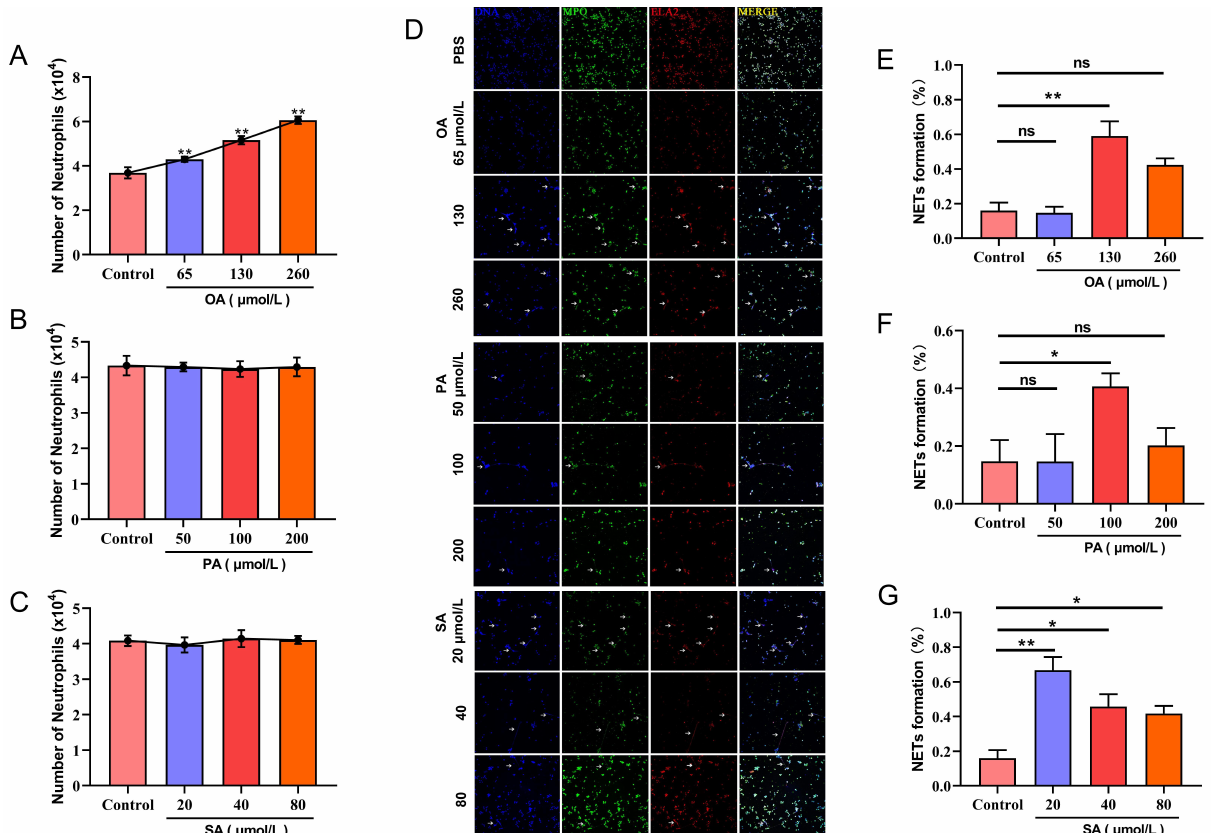
Figure 2. Effects of OA, PA, and SA on migration and NET formation of PMN. ( A ) Effects of OA on migration of PMN; ( B ) effects of PA on migration of PMN; ( C ) effects of SA on migration of PMN; ( D ) effects of OA, PA, and SA on NET formation of PMN (white arrows: NET); ( E ) effects of OA on the percentage of NET formation; ( F ) effects of PA on the percentage of NET formation; ( G ) effects of SA on the percentage of NET formation. Data are shown with means ± SD ( n = 3). * p < 0.05, ** p < 0.01, compared to control